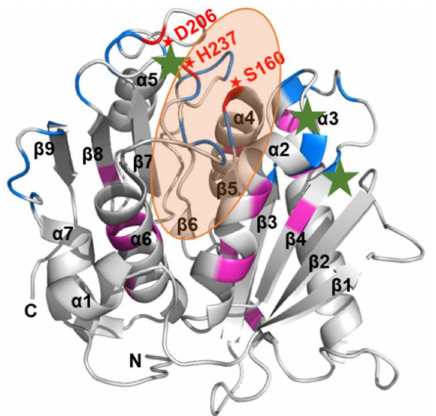
Figure 5. Three-dimensional ribbon representation of the WT PETase. A PETase enzyme displayed the nomenclature for N-terminus (N), C-terminus (C), all alpha helices ( α 1– α 7), and all beta strands ( β 1– β 9). Catalytic residues (S160, D206, and H237), and the selected mutated residues 112, 119, and 238, were denoted by red and green stars, respectively. The orange shadow represented the binding pocket. Amino acid sequences in the loop or non-loop regions were highlighted with blue or pink (related to Figure